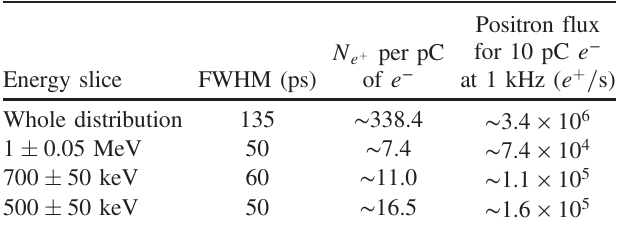
TABLE I. Temporal duration and number of positrons after the dogleg for different energy slices. The positron flux is given assuming a 10 pC primary electron bunch at a 1 kHz repetition rate.